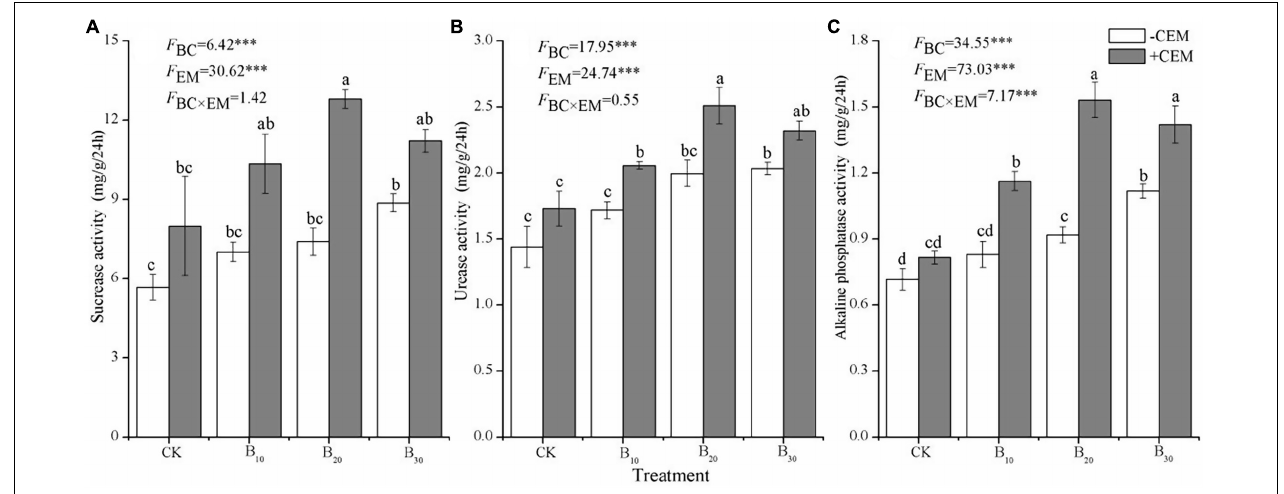
FIGURE 5 | Soil sucrase activity (A) , soil urease activity (B) , and soil alkaline phosphatase activity (C) under different treatments. Different lowercase letters referred to significant difference between treatments ( p < 0.05). The F BC , F CEM , and F BC × CEM are F and the degree of freedom of two-way ANOVAs. ∗∗∗ p < 0.001.